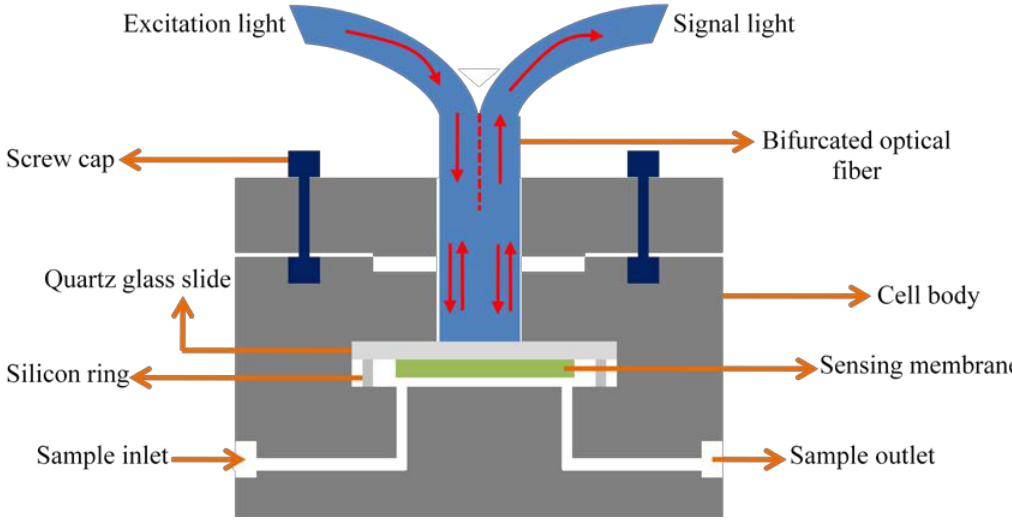
Figure 3. Schematic diagram of a bifurcated optical fiber flow cell